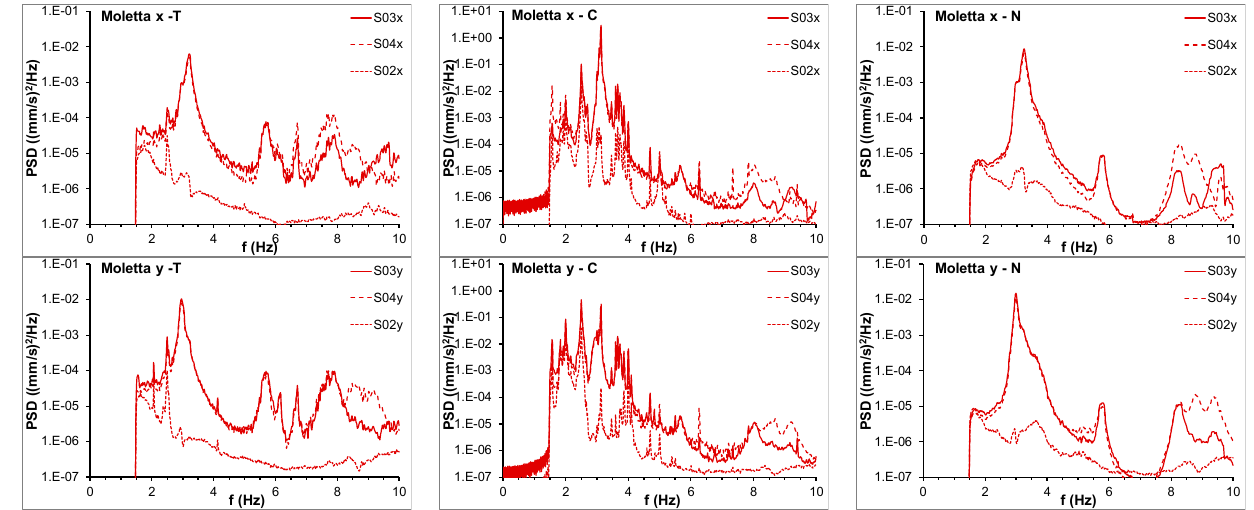
Figure 9. PSDs in the three directions (at S02, S03, and S04) for the three time intervals (T, C, and N). In Figure 10, the cross spectral density (CSD) graphs of the parallel velocity compo- nents at S02 and S04 and at S03 and S04 are separately plotted for the three intervals (T, C, and N). The already-mentioned resonance frequencies are also pointed out. S03 and S04 are in phase at 3.0 and 3.25 Hz, while they are out of phase at 5.8 Hz. Therefore, the first two frequencies are associated with the first modal shape of the tower along the y and x direction, respectively, the third one to the second modal shapes, which have very similar frequencies.